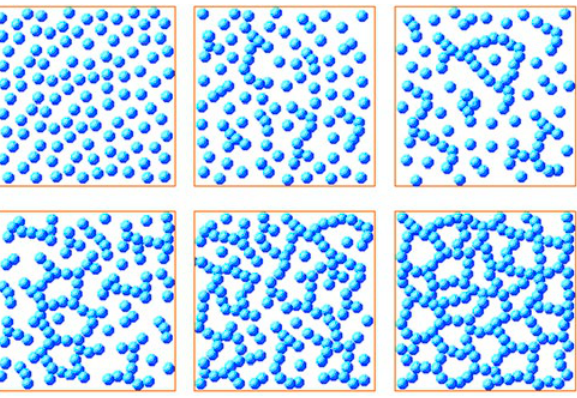
Figure 48. The gelling process involves formation of an increasing amount of the sol being converted to microgel with increasing vis- cosity until it solidifies. This “solidification” in the first instance is achieved when there is sufficient three-dimensional cross linking to entrap the solvent in pockets. Initially it is a wet weak watery gel which becomes essentially a dispersion of solvent in “spongy” solid. A gel is by definition a visco-elastic solid with all linked parts of the meshwork immobilised in relation to all other linked parts. It is “sensitive” to disruption by shock or shear (thixotropic). [From Iler, 1979, p.